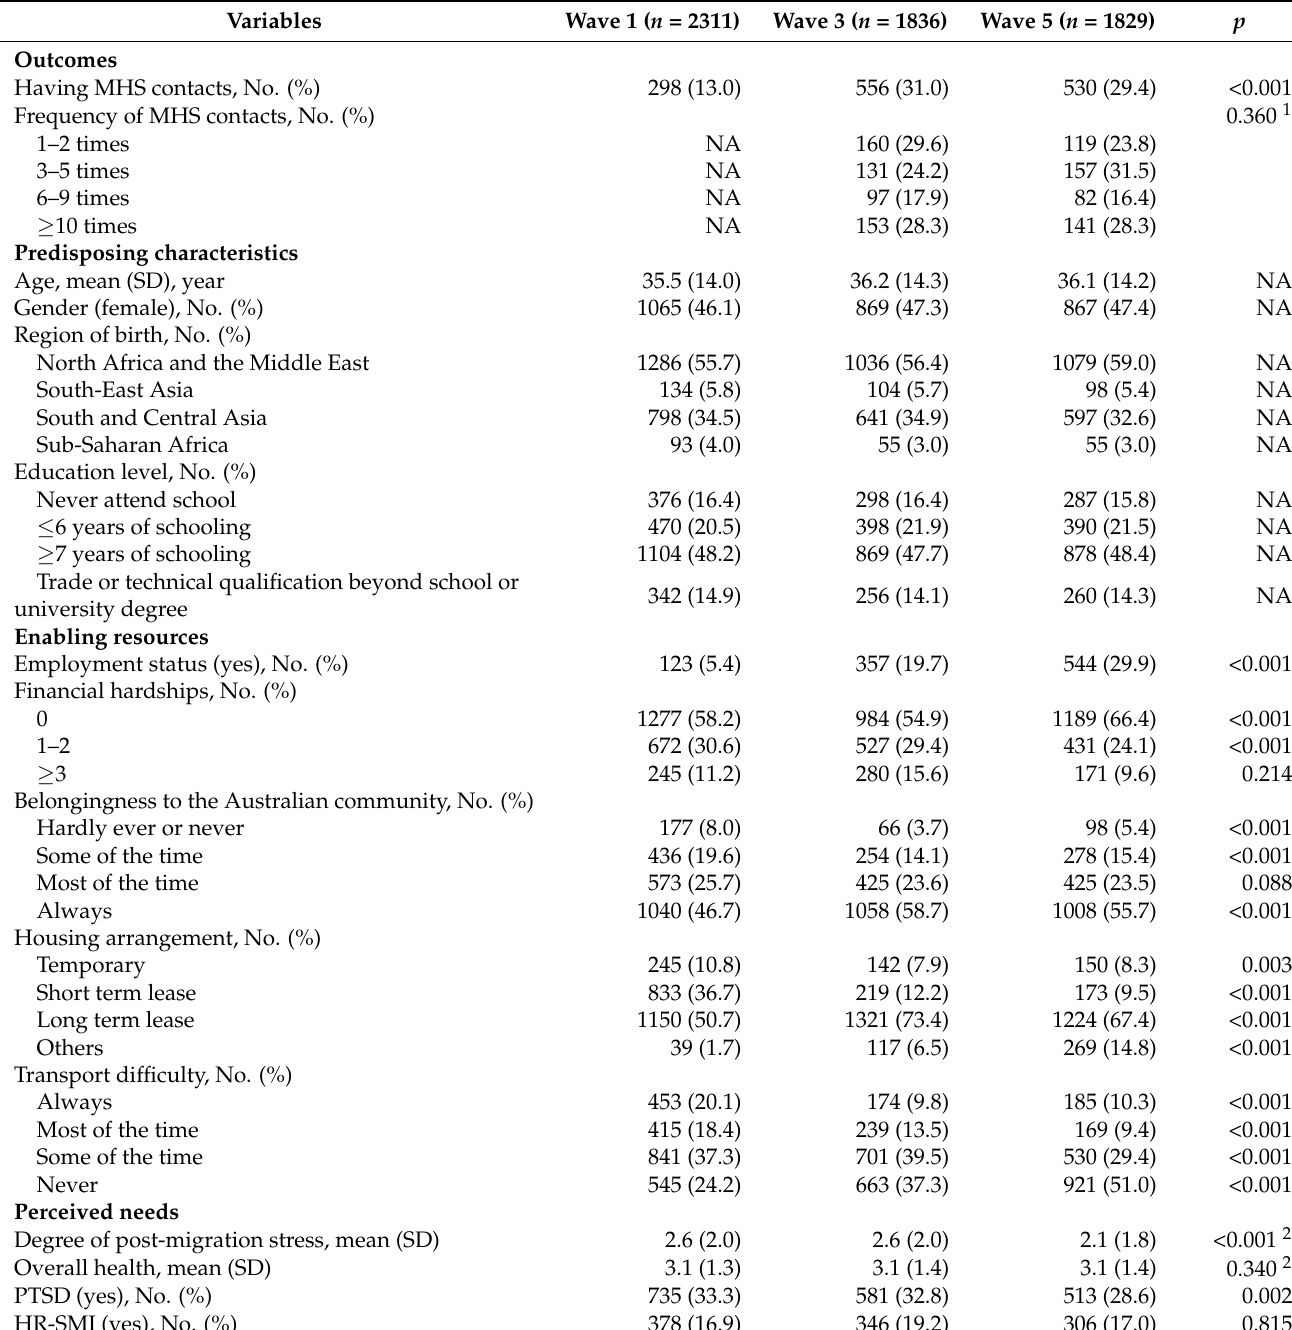
Table 1. Individual characteristics and mental health service utilization of BNLA humanitarian migrants at three